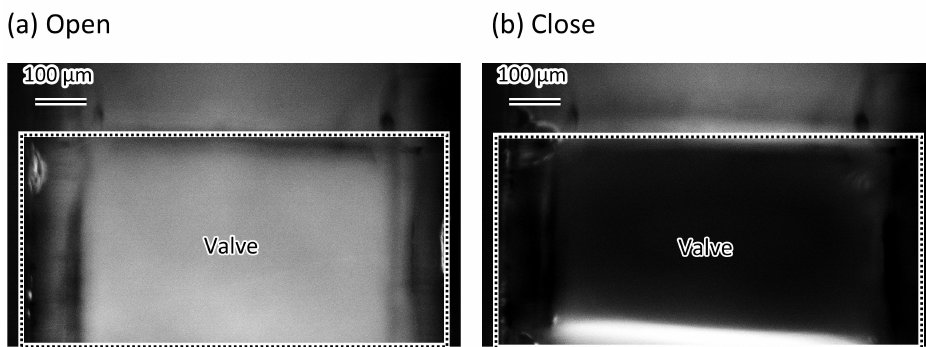
Figure 11. Difference between images of the fluorescent micrograph of the microvalve operation with and without fluorescent dye. ( a ) Corner of the microvalve is filled with fluorescent dyed water when the microvalve is open; ( b ) Fluorescent dyed water at the corner of the microvalve cannot be observed when the microvalve is